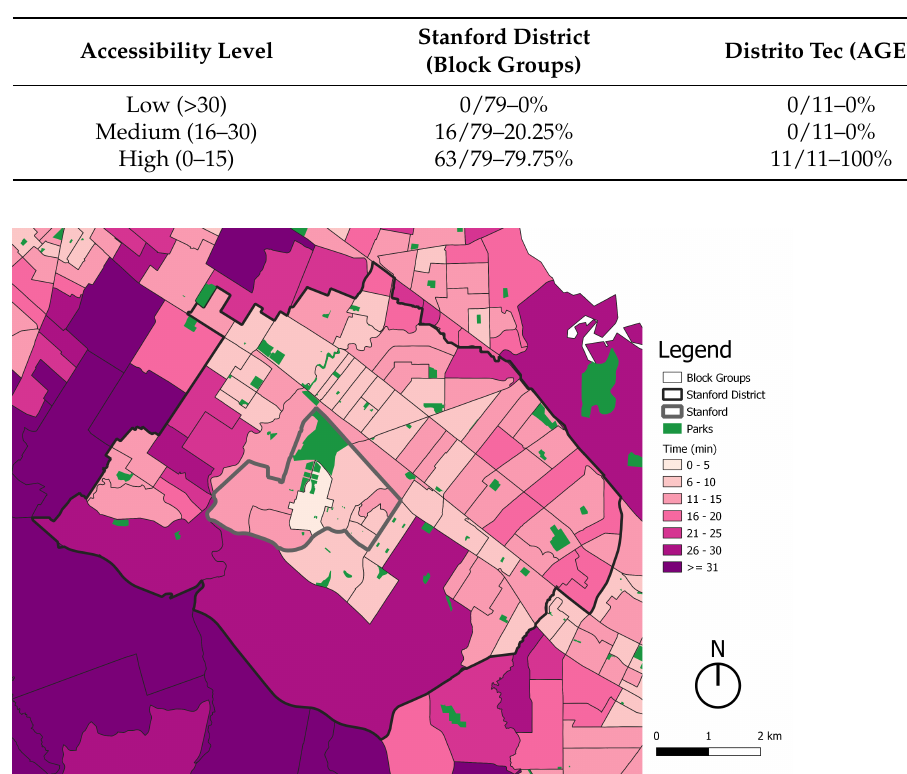
Figure 17. Distrito Tec average travel time to the 3 closest public high schools by bicycle. Table 12. Accessibility level to parks traveling by foot per aggregation area.